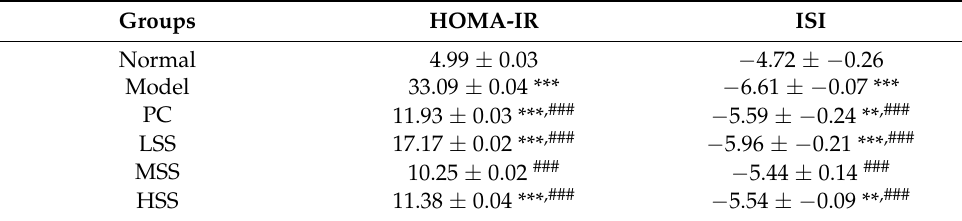
Table 1. Effects of oral SS administration on HOMA-IR and ISI values in T2D rats.